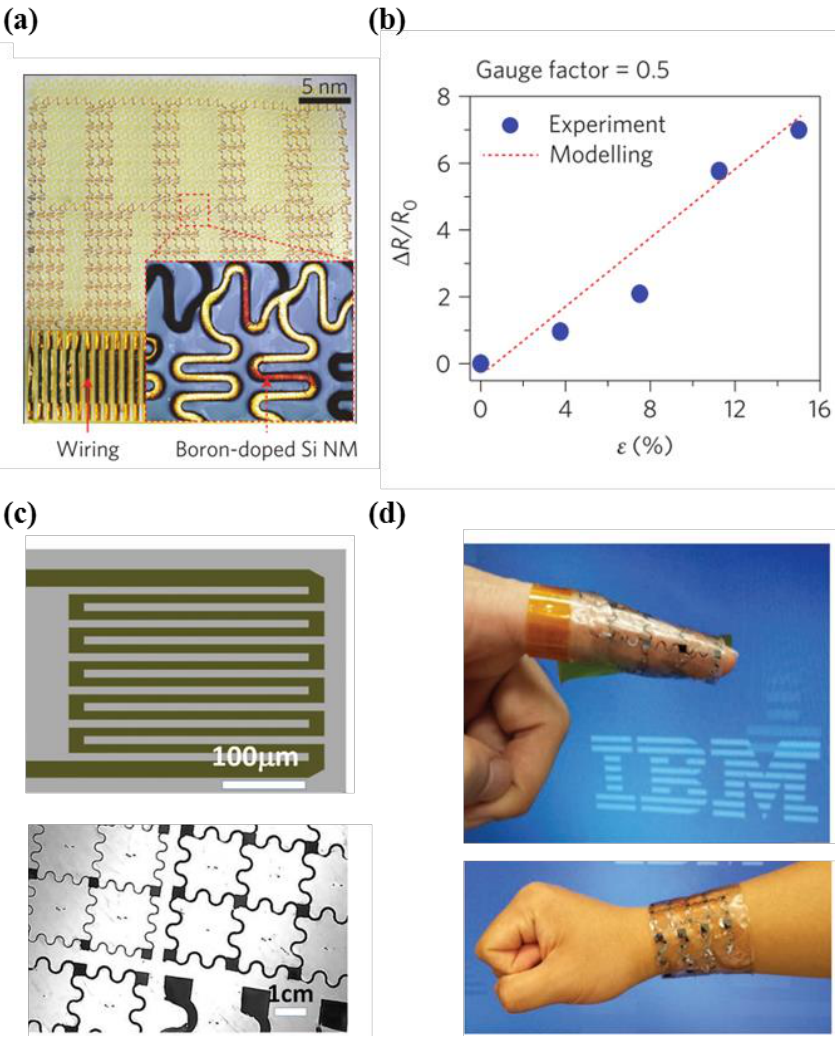
Figure 9. ( a ) Photographic image of silicon strain sensor and location of boron-doped silicon nanomembrane; ( b ) the relative change in resistance versus strain (%) with modeling data (reprinted with permission for Figure 9a,b from Ref. [11] Copyright 2014 Springer Nature); ( c ) image of strain gauge with the serpentine shape pattern and picture of device on tape without stress layer; ( d ) photographic image showing e-skin applications on the finger and wrist (reprinted with permission for Figure 9c,d from Ref. [77] Copyright 2017 John Wiley and